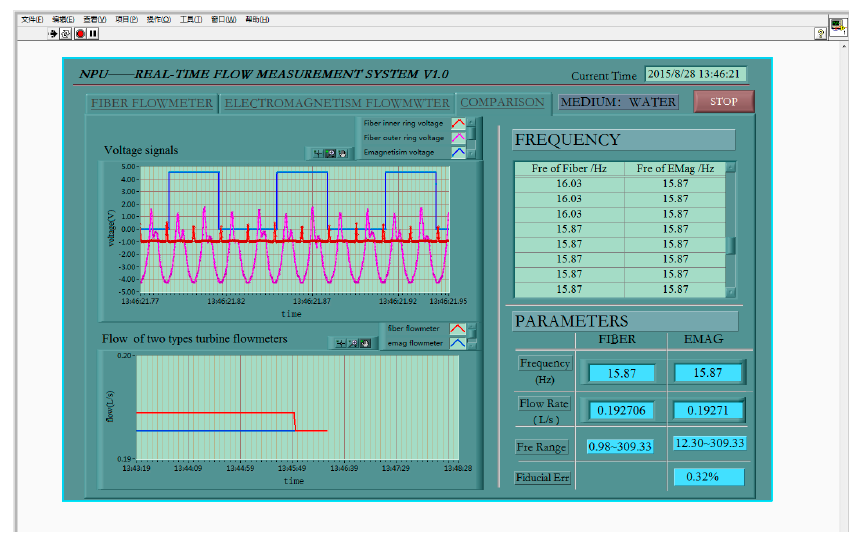
Figure 9. Test display interface of fiber turbine flow sensor contrast with electromagnetic method in the linear range.